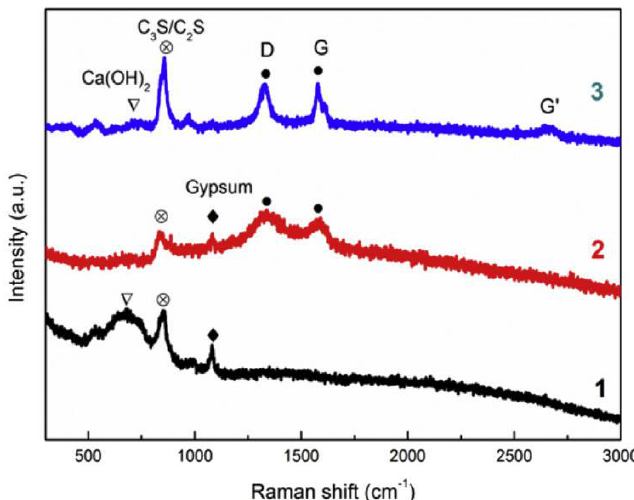
Figure 16. Raman results of (1) Plain cement sample; (2) GO; (3) Graphene/cement sample. Reprinted with permission from Ref. [45]. Copyright 2017 Elsevier.